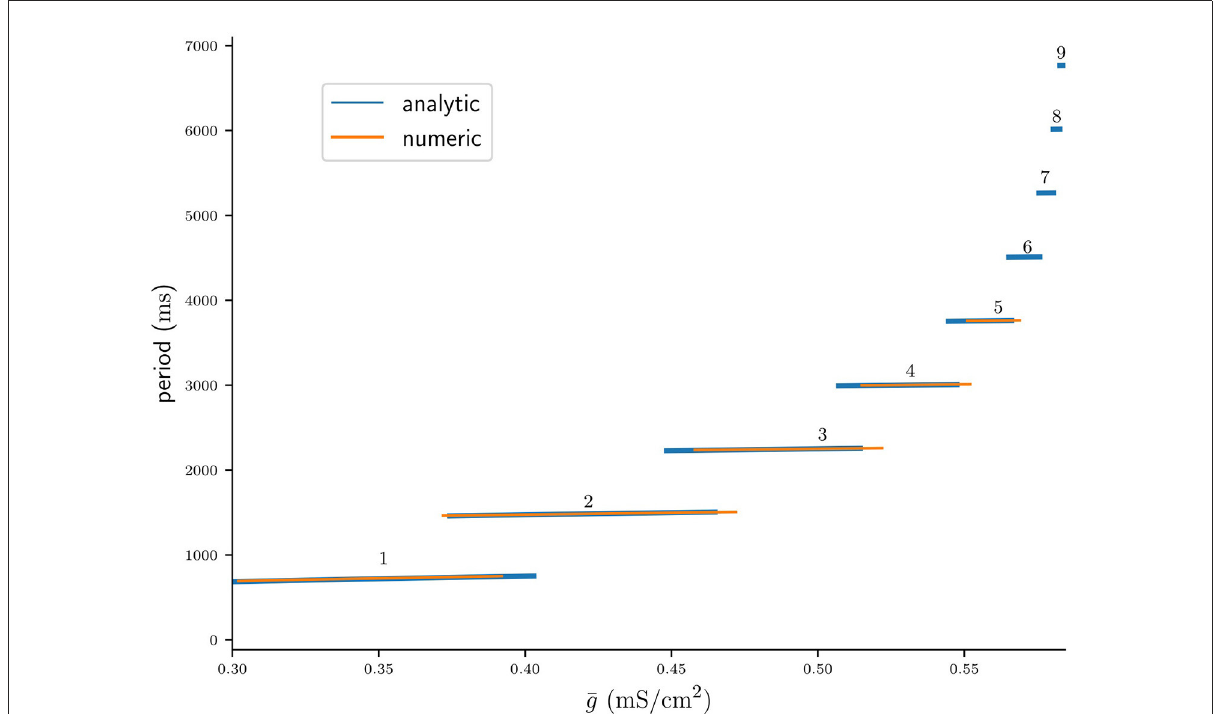
FIGURE10 Bifurcation diagram of the period of stable n : n solutions computed analytically from fixed points of 5 n , plotted on the respective intervals of ¯ g ∈ (cid:2) ¯ g L ( n ), ¯ g R ( n ) (cid:3) (blue), and computed from numerical integrations of the ODEs